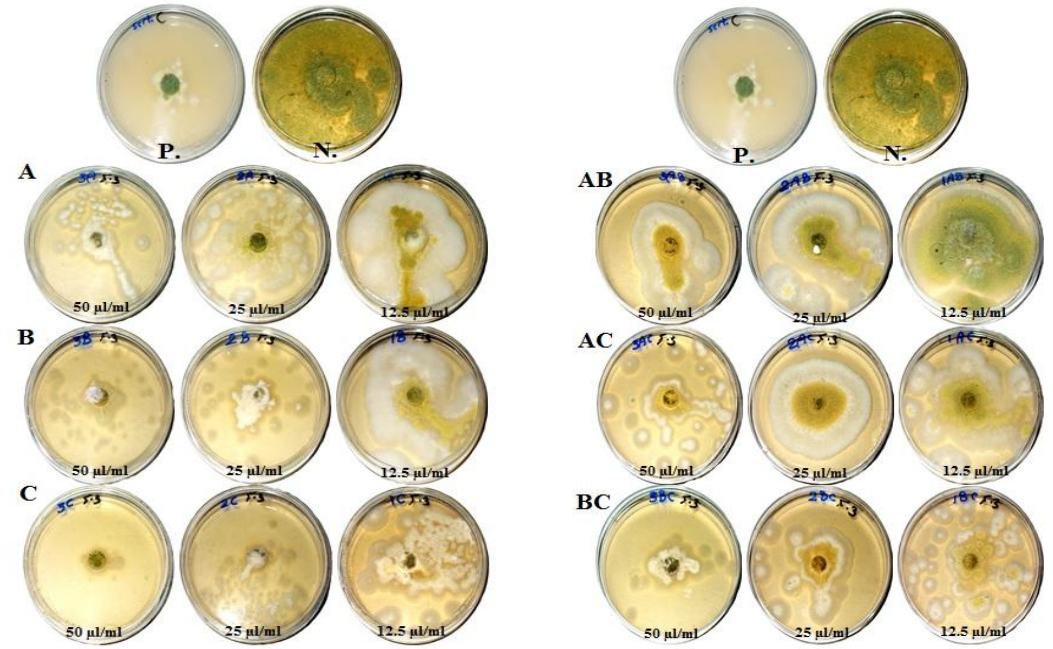
Figure 2. Visual observation of A. flavus growth inhibition as affected by the essential oils from ( A ) C. aurantium oil, ( B ) E. camaldulensis oil, and ( C ) C. sinensis oil and their combinations. ( P ) Positive control (Sertaconazol 3 g/L). ( N ) Negative control (DMSO 10%). ( AB ) C. aurantium oil + E. camaldulensis oil. ( AC ) C. aurantium oil + C. sinensis oil. ( BC ) E. camaldulensis oil + C. sinensis oil.